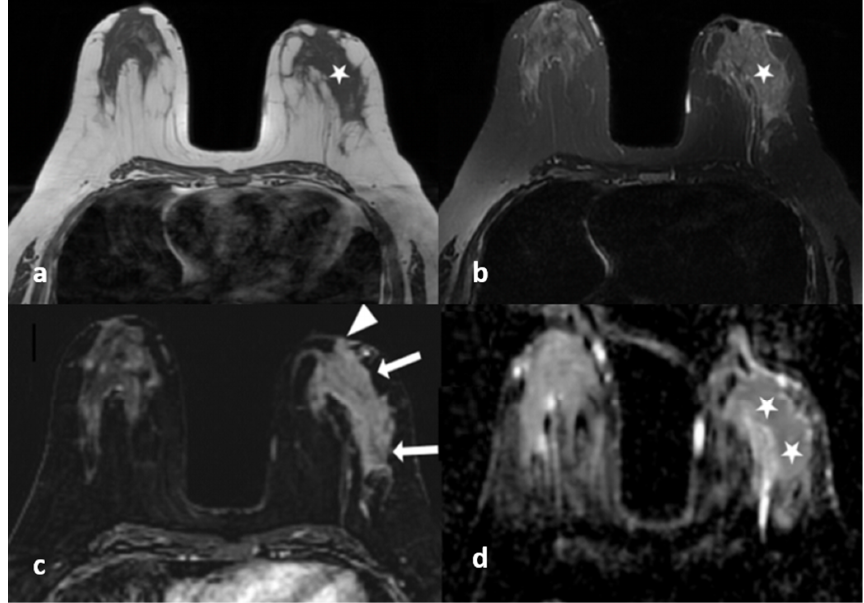
Figure 4. A 40-year-old woman with histopathologically proven idiopathic granulomatous mastitis involving the left breast. ( a ) T1-weighted fast spin echo axial MR image of the patient shows mild parenchymal asymmetry in the upper outer quadrant of the left breast (star.) ( b ) Axial fat-saturated T2-wieghted fast spin echo MR image, corresponding to ( a ), which reveals a moderate signal in- crease in the parencyma (star). ( c ) Axial contrast-enhanced subtracted image demonstrates a heter- ogeneous enhancement in the parenchyma (arrows) and a pathologic enhancement extending to the skin in the periareolar region (arrowhead). ( d ) ADC map at the same location shows a moderate signal decrease (stars) revealing restriction of di ff usion in the area corresponding to ( a – c ). There was a signi fi cant di ff erence regarding the distribution of non-mass enhance- ment in the multiple regional and di ff use distribution categories (Table 3). Multiple re- gional distribution was more common in IGM, whereas di ff use distribution was more common in breast cancer ( p : 0.048). There was no di ff erence in terms of linear or segmental distribution pa tt erns. In terms of internal enhancement pa tt erns, there was a signi fi cant di ff erence only in the clumped pa tt ern (Figure 5), which was more common in breast can- cer (22.7% versus 4.4%) ( p < 0.05). Clustered ring pa tt ern was seen in 40 patients with IGM (58.8%) and 38 patients with breast cancer (50.7%); the di ff erence was not statistically sig- ni fi cant (Figure 5).